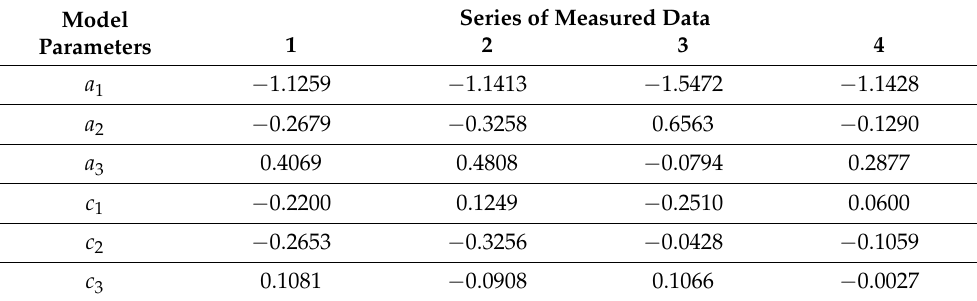
Table 3. Parameters of third-order ARMA models estimated for successive series of measured